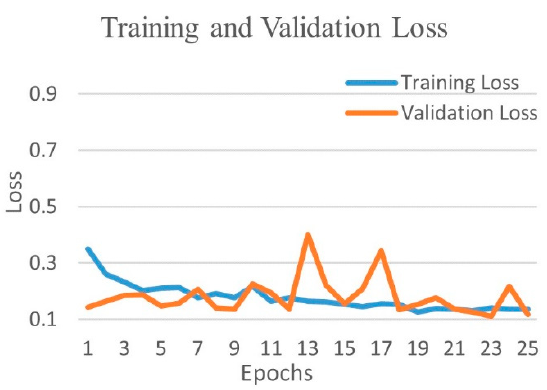
Figure 17. Training and validation loss of best performing VGG16 model for three-class experiment.